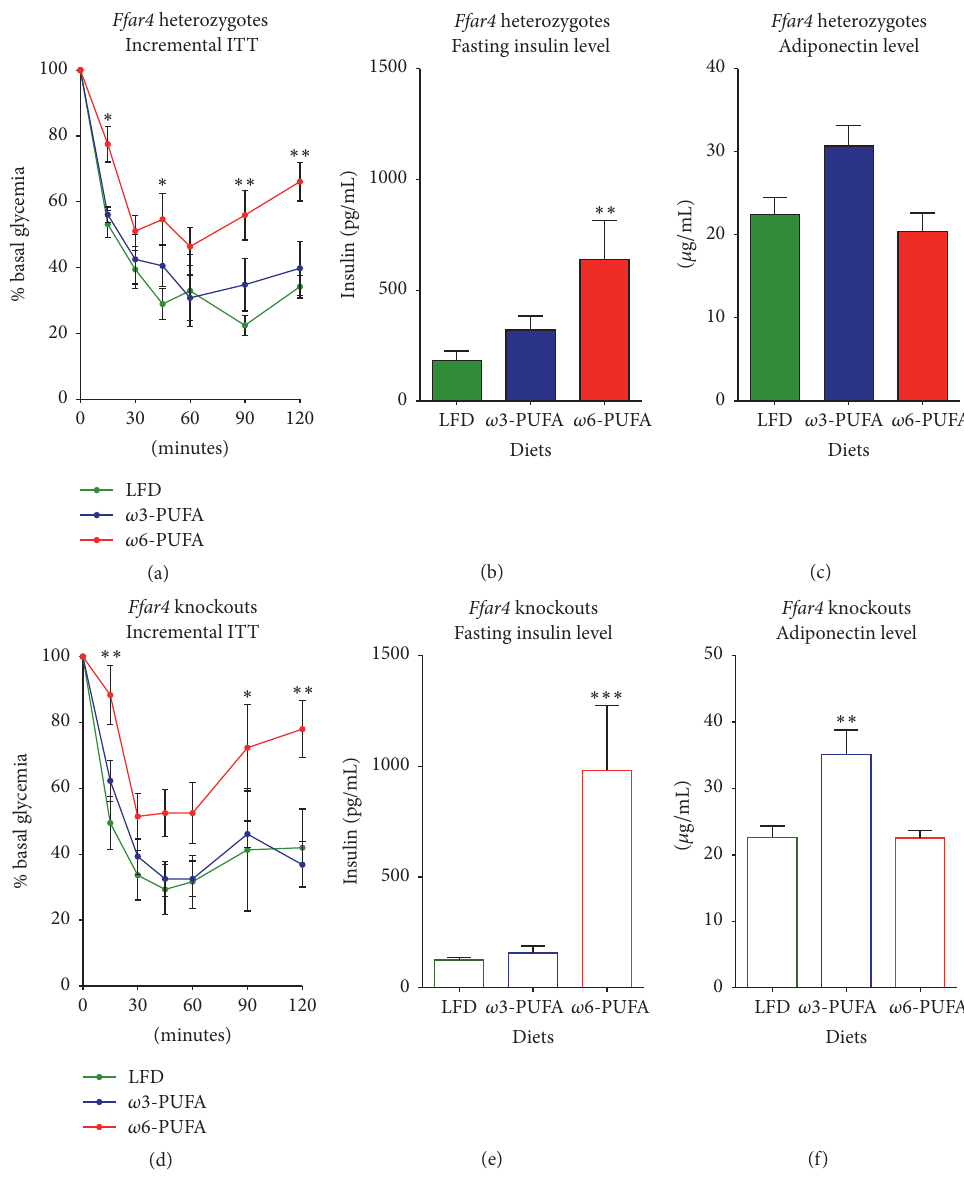
Figure 2: Ffar4 HET and KO mice are protected against insulin resistance on a high fat 𝜔 3-PUFA diet. Insulin tolerance tests were performed at week 33 after diet initiation in 2-hour food-deprived mice. An insulin bolus of 1U/kg lean mass was injected i.p. ((a)–(c)) Heterozygotes. ((d)–(f)) Knockouts. ((a) and (d)) ITT, 𝑛 = 4 –8; ((b) and (e)) 5-hour fasting insulin levels 32 weeks after diet initiation, 𝑛 = 6 –8. ((c) and (f)) Plasmaadiponectinlevels36weeksafterdietinitiation, 𝑛 = 4 –7.Alldataarepresentedasmeans ± SEM.BothHFDshavebeencomparedtothe LFD. For (a) and (d), 2-way RM ANOVA with Bonferroni correction was performed. All bar graph data were Ln-transformed and subjected to 1-way ANOVA with Bonferroni correction. Only statistical significant differences are shown. ∗ 𝑝 < 0.05 , ∗∗ 𝑝 < 0.01 , and ∗∗∗ 𝑝 < 0.001 .